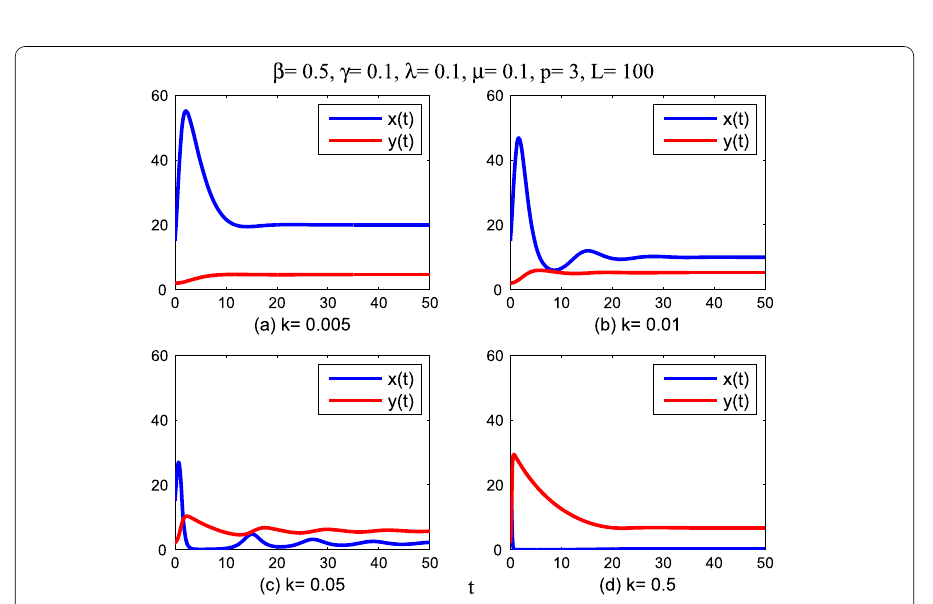
Figure 4 The curves of the target cells x ( t ) and the induced immune cells y ( t ) at λ = 0.1, μ = 0.1, β = 0.5, γ = 0.1, p = 3, and L = 100 and different values of the parameter